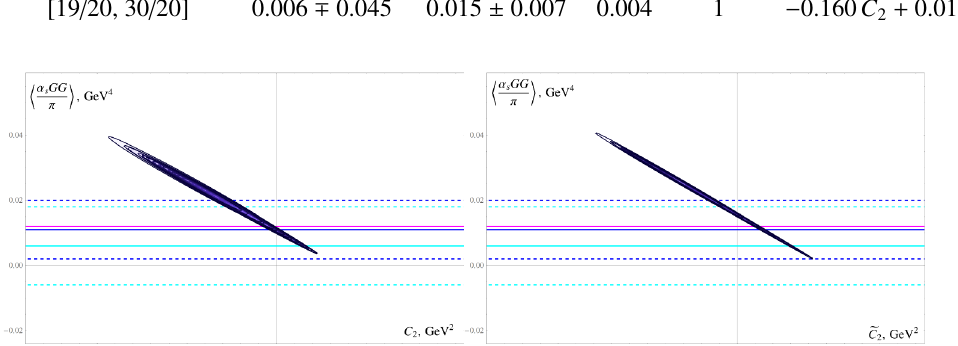
+ 1, χ 2 ≤ χ 2 + 2, χ 2 ≤ χ 2 + 3 for PT (left panel) and APT (right min min min